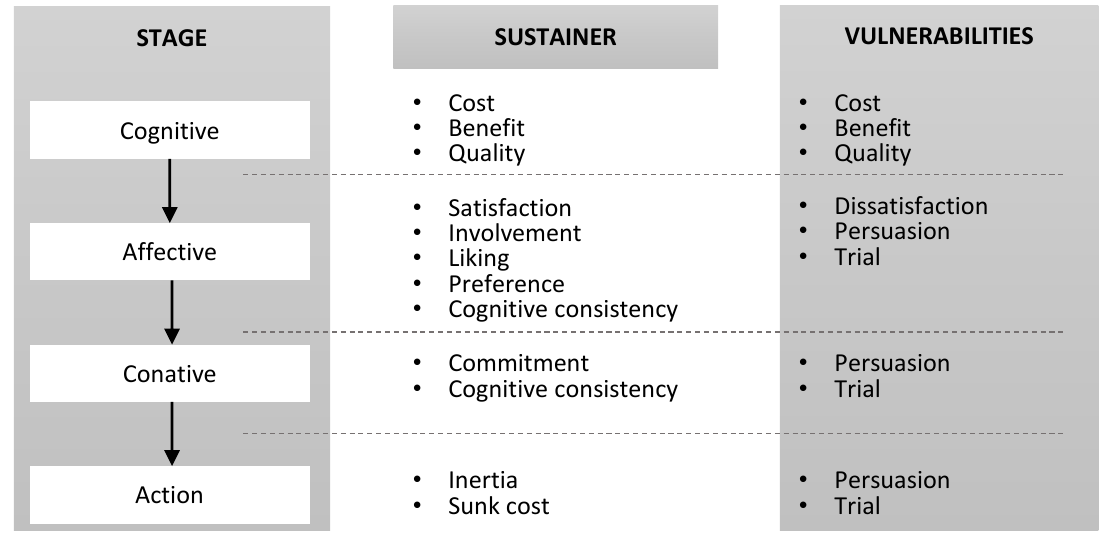
Figure 1. Four-stage loyalty model: sustainer and